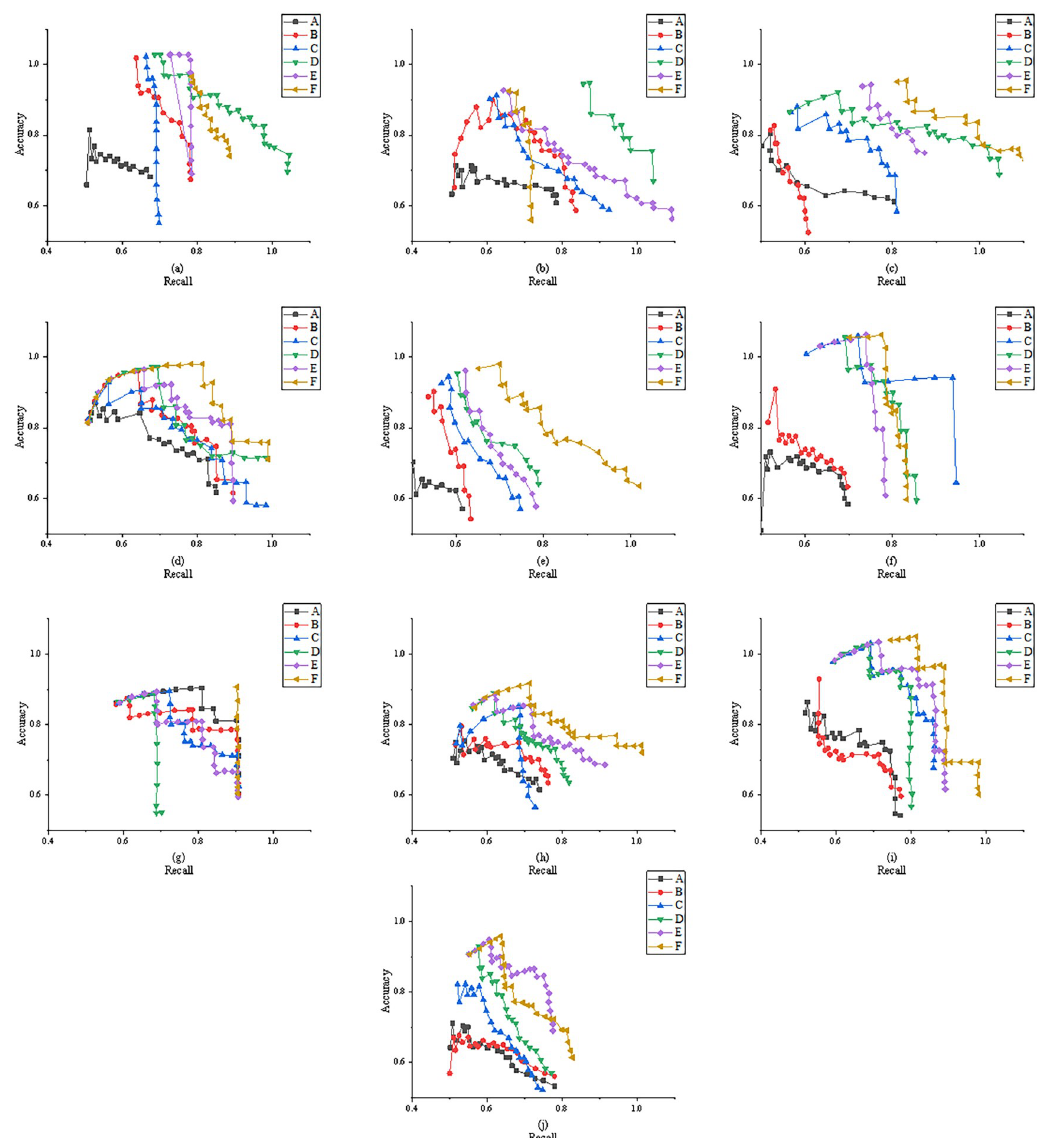
Fig 5. PR curves of different comparison algorithms on VHR-10 data set (A: FRCN-ZF; B: FRCN-VGG; C: SSD; D: YOLO v1; E: YOLO-v5; F: YOLO-v5+ R-FCN; a: Aircraft; b: Boat; c: Storage tank; d: Baseball field; e: Tennis court; f: Basketball court; g: Track-and-field ground; h: Port; i: Bridge; j: Vehicle).